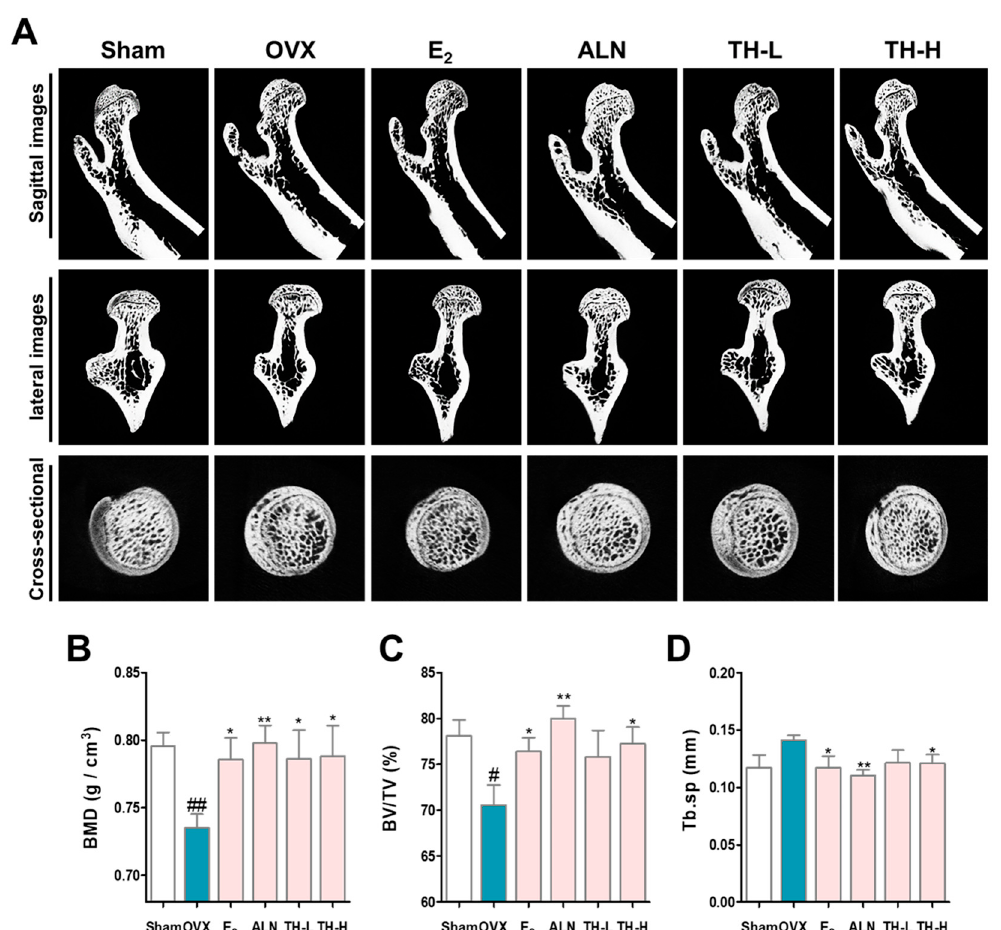
Figure 7. Taraxaci Herba (TH) increased the decreased bone density. ( A ) Representative micro–computed tomography (micro-CT) images of the femurs. Relative bone microstructure changes in ( B ) bone mineral density (BMD), ( C ) bone volume/total volume (BV/TV), and ( D ) trabecular separation (Tb.Sp) were measured using NRecon software. The experiments’ representative images are shown, and the graphs are expressed as the mean ± standard error of the mean (SEM; n = 8). # p < 0.05, ## p < 0.01 vs. sham group; * p < 0.05, ** p < 0.01 vs. OVX